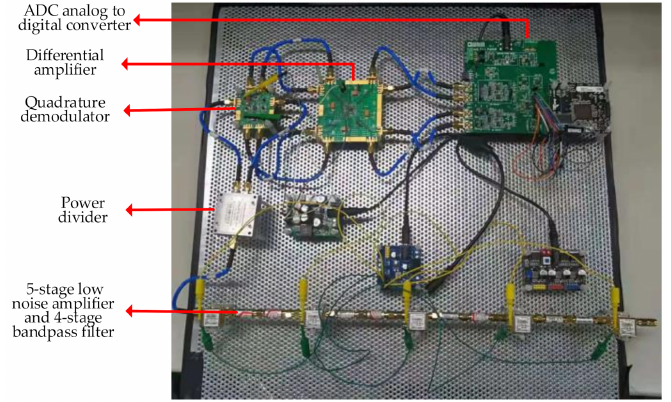
Figure 7. Prototype of interferometric microwave thermometry